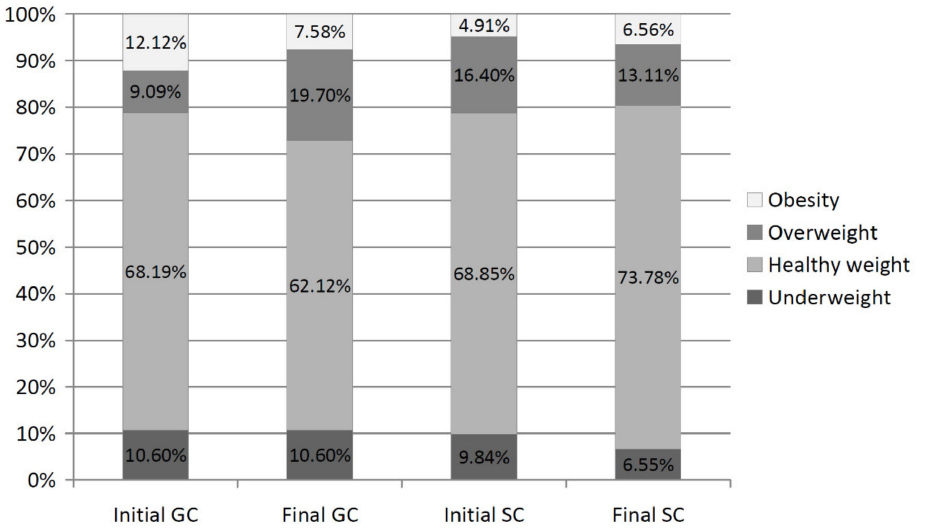
Figure 5. The percentage of boys in particular body mass categories—comparison between the initial and final measurement